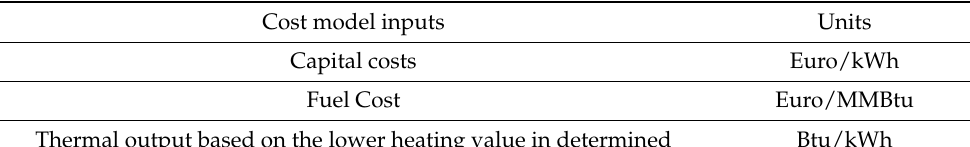
Table 3. Cost model